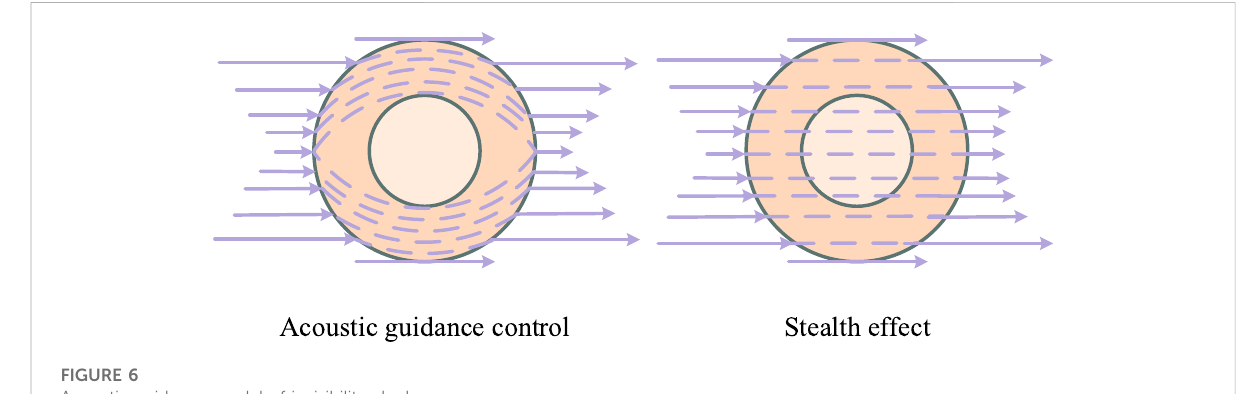
Acoustic guidance model of invisibility